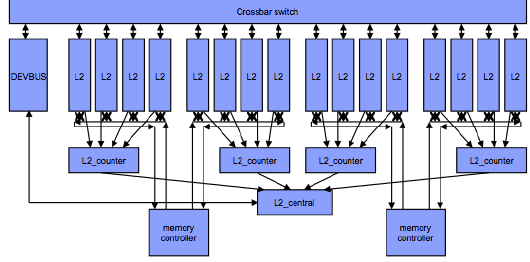
Figure 3. L2 cache of BlueGene/Q Compute Chip